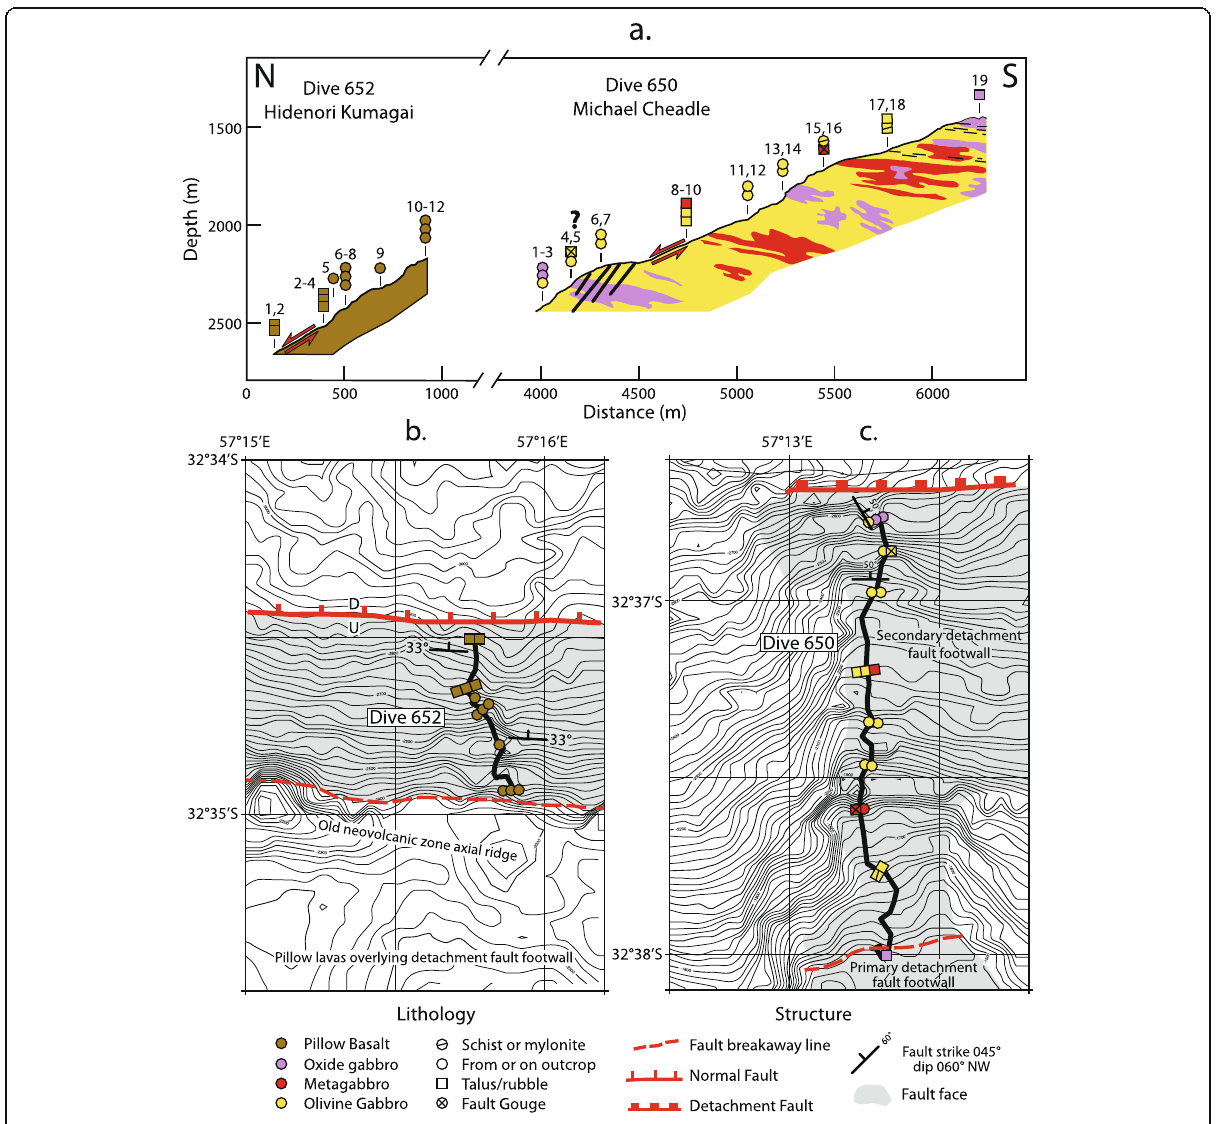
Fig. 20 a Geologic interpretations of Dives 652 (left) and 650 (right) on the 32° 35 ′ N and 32° 40 ′ S secondary detachment fault faces, respectively. b Dive 652 plan view showing high-angle normal fault face. Thick black lines are navigated dive tracks. c Dive 650 traverse up the north-facing secondary detachment footwall and the fault breakaway zone separating it from the primary detachment fault footwall at the north end of the Atlantis Bank gabbro massif. Profiles represent distance along track, rather than a straight line up a constant azimuth. Scientific divers H. Kumagai and M. Cheadle as indicated on the